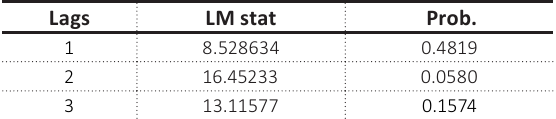
Table 2. Autocorrelation in the residuals